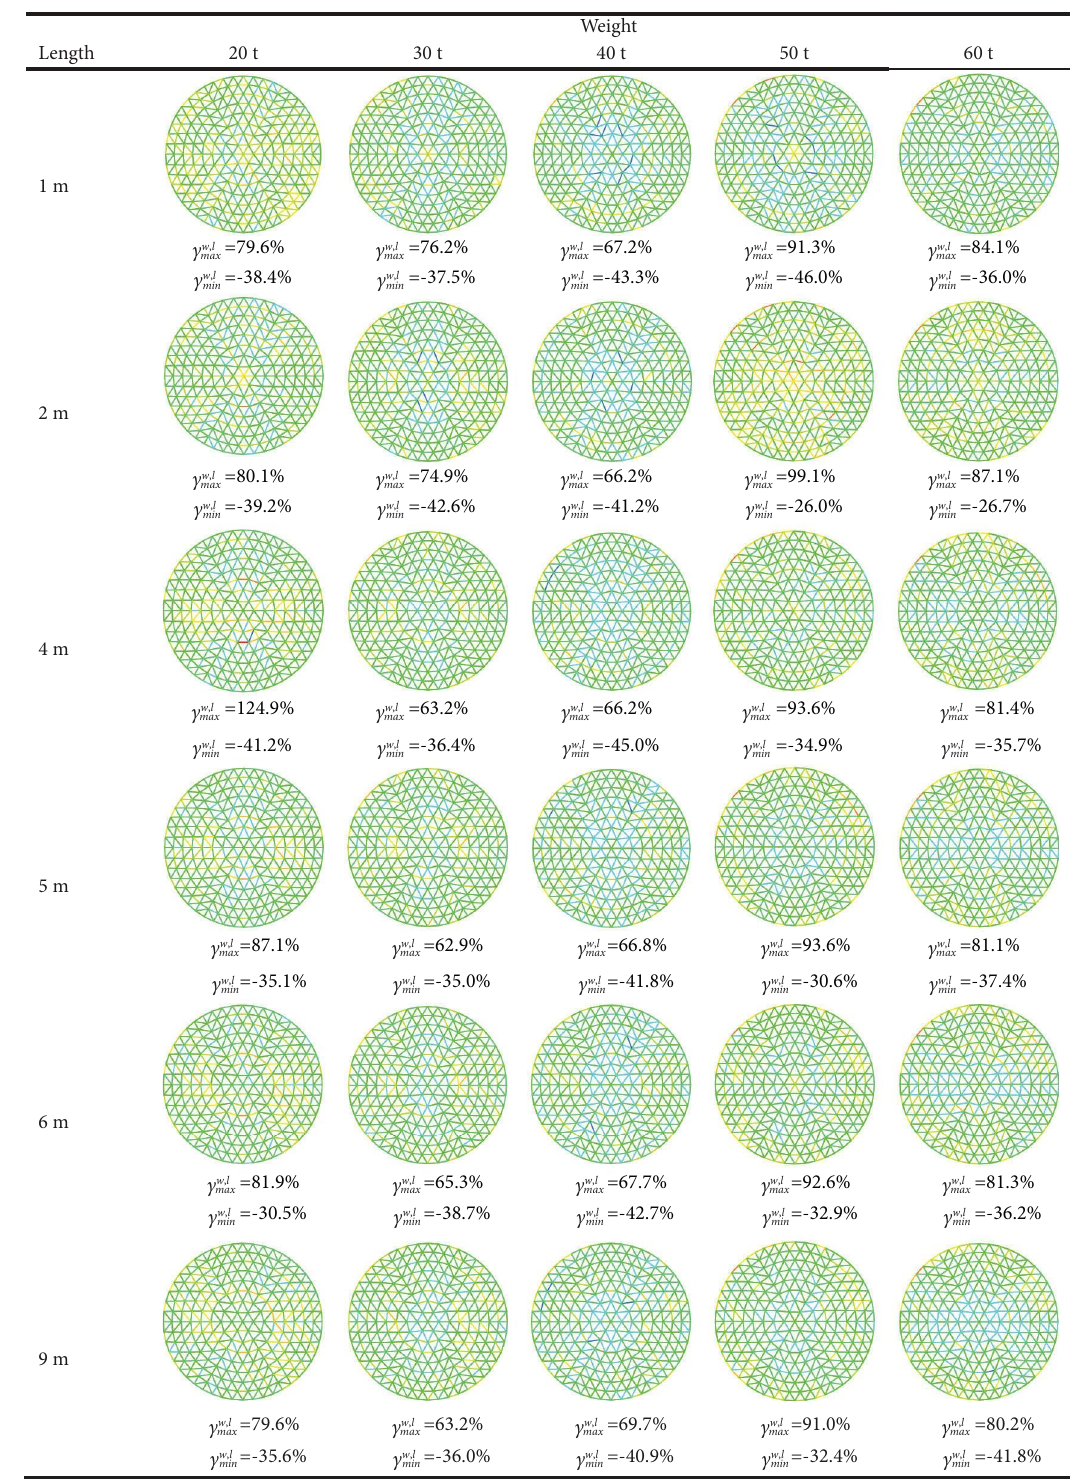
Table 2: Contours of the change rate c w,l j, max of the reticulated shell